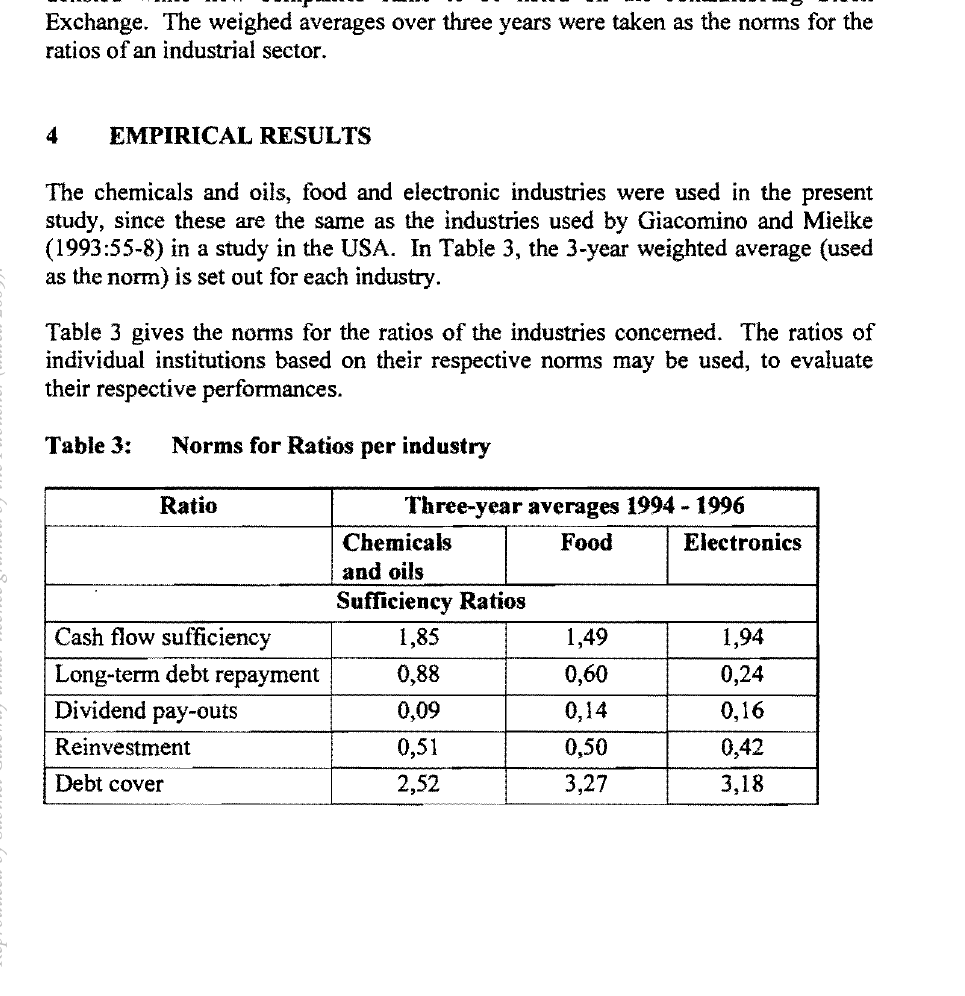
Numver ofinstitutions in Industry